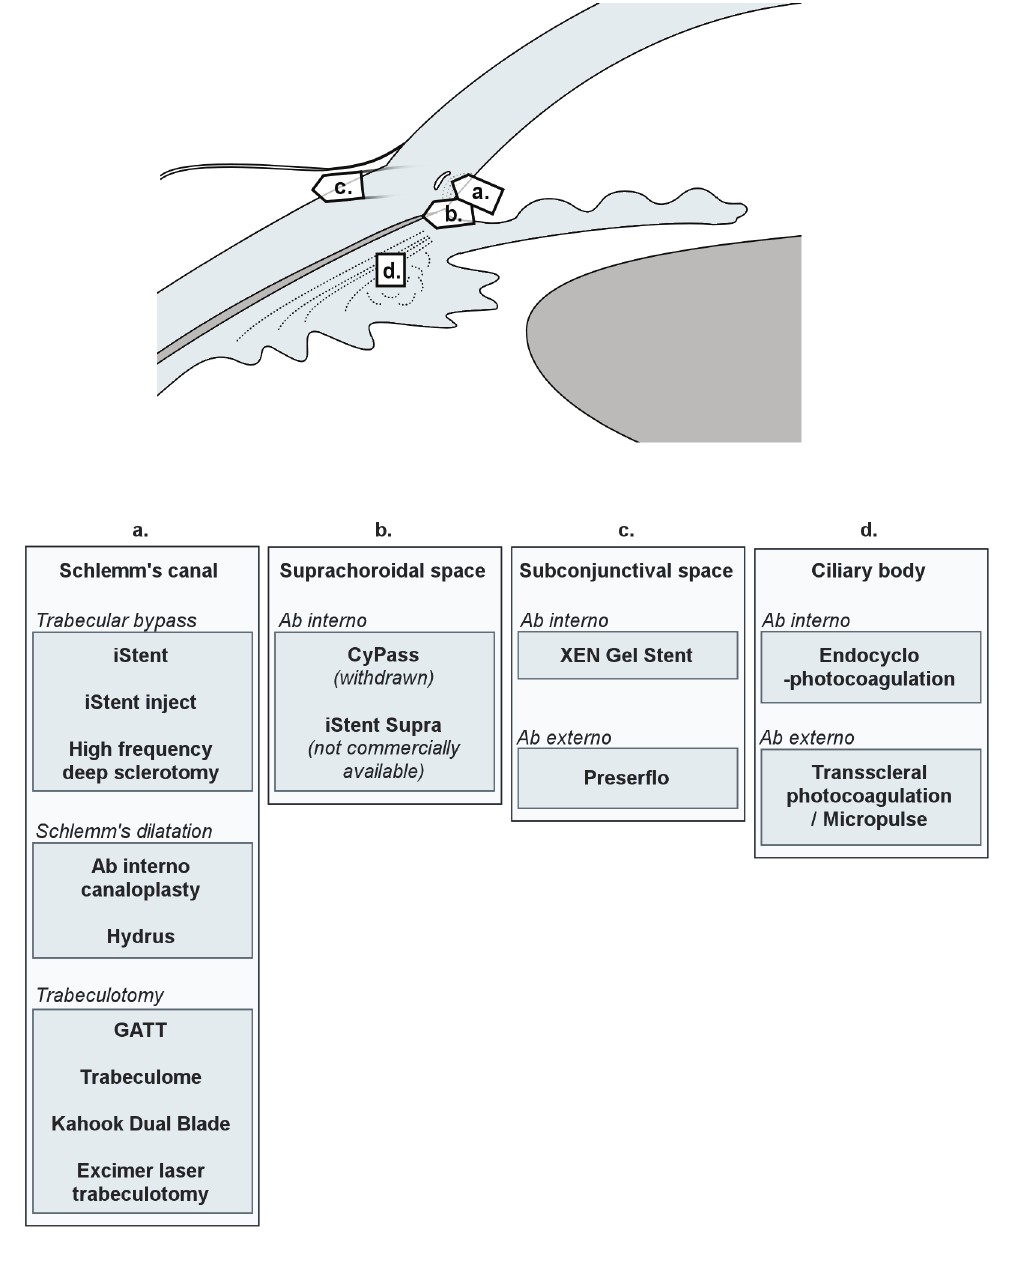
Figure 1. Illustration of the different classes of minimally invasive glaucoma surgery, their anatomical relationship with the ocular structures (top), and examples of implants and techniques available in each